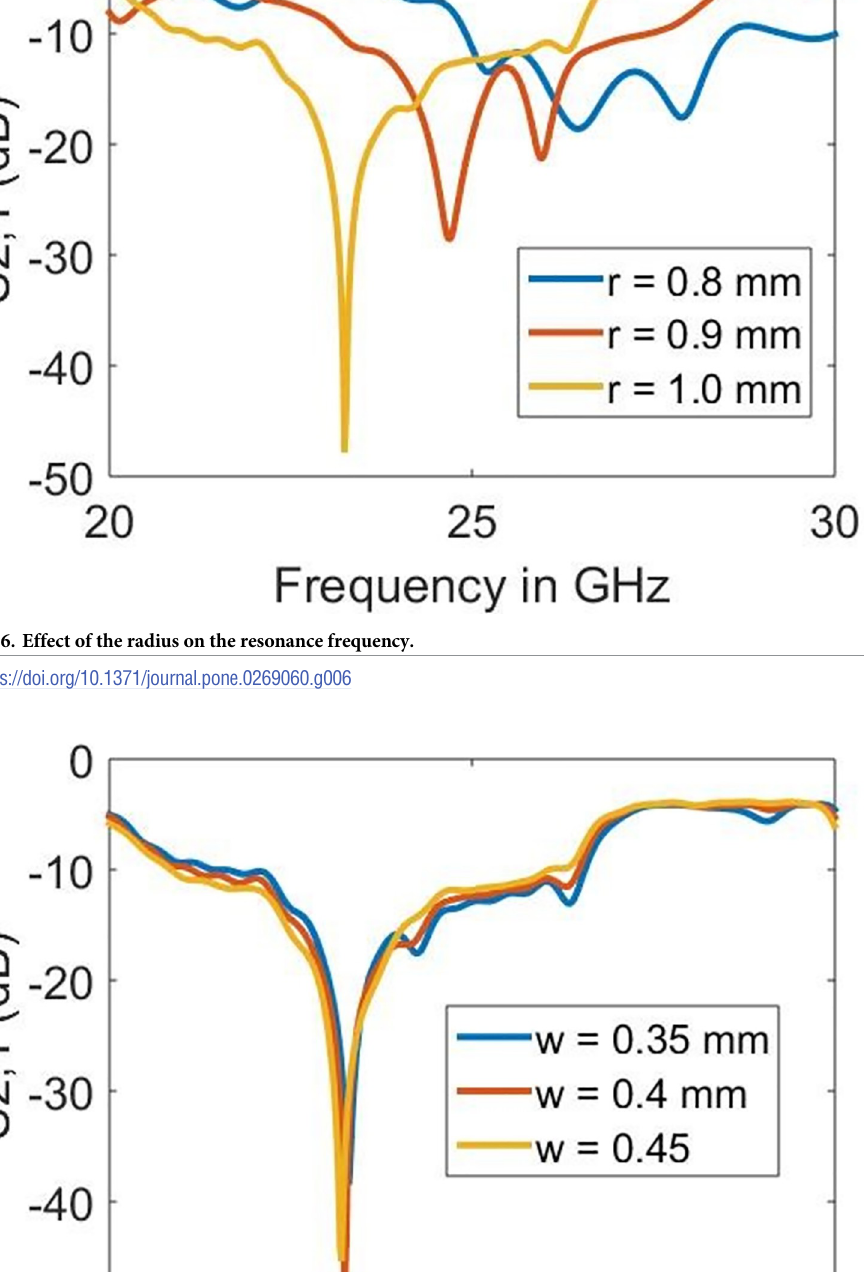
PLOS ONE | https://doi.org/10.1371/journal.pone.0269060 June 29,